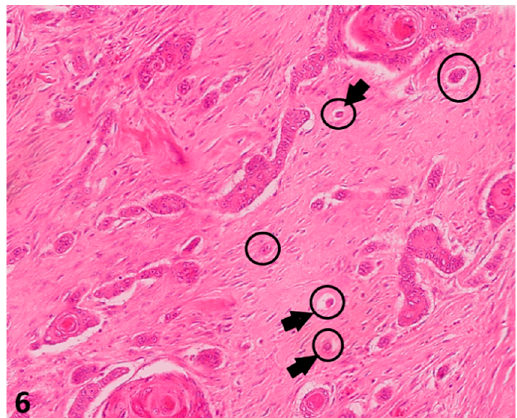
Figure 6. (O.M. 4×): Histological pictures (Hematoxylin–Eosin (HE) stain) illustrating tumor budding in a canine digital squamous cell carcinoma: Only complexes of less than five cells were counted in 10 HPF (40×) in the area of biggest incidence (delineation) within the invasive front. O.M: original magnification.